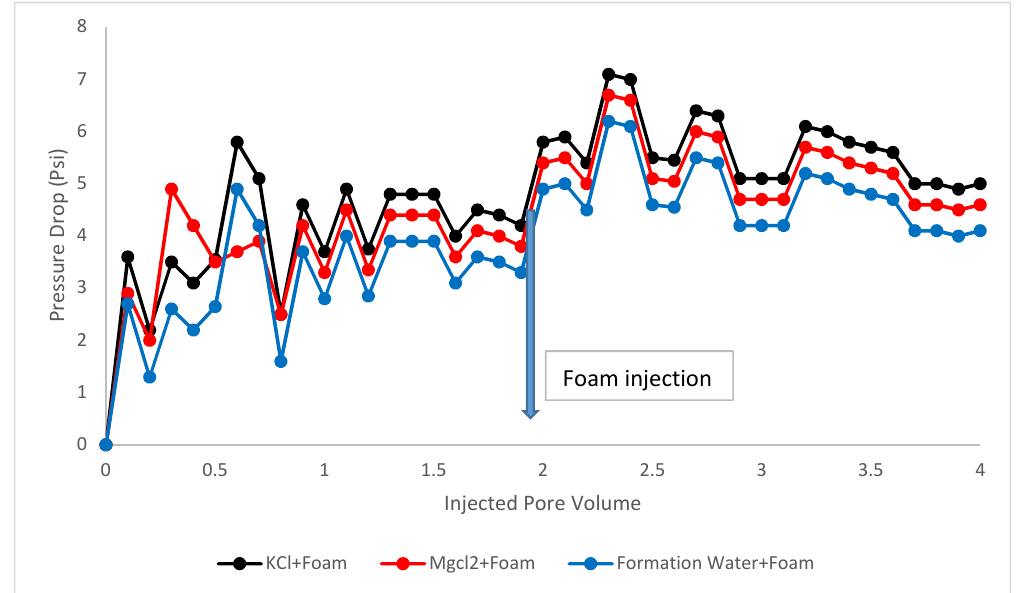
Figure 4. Pressure drop for different scenarios.